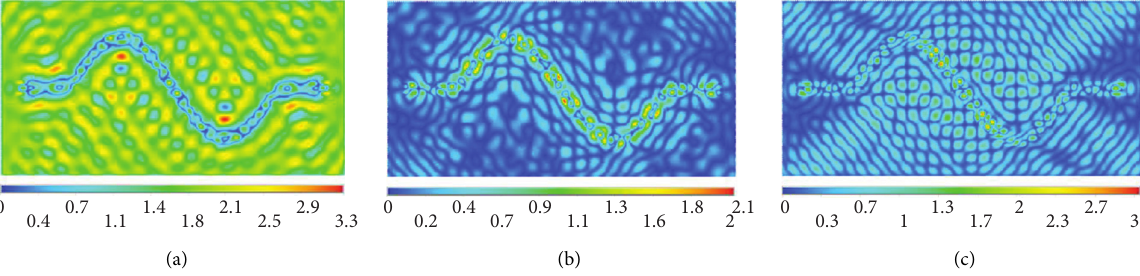
u u x , (b) y , and (c) z .